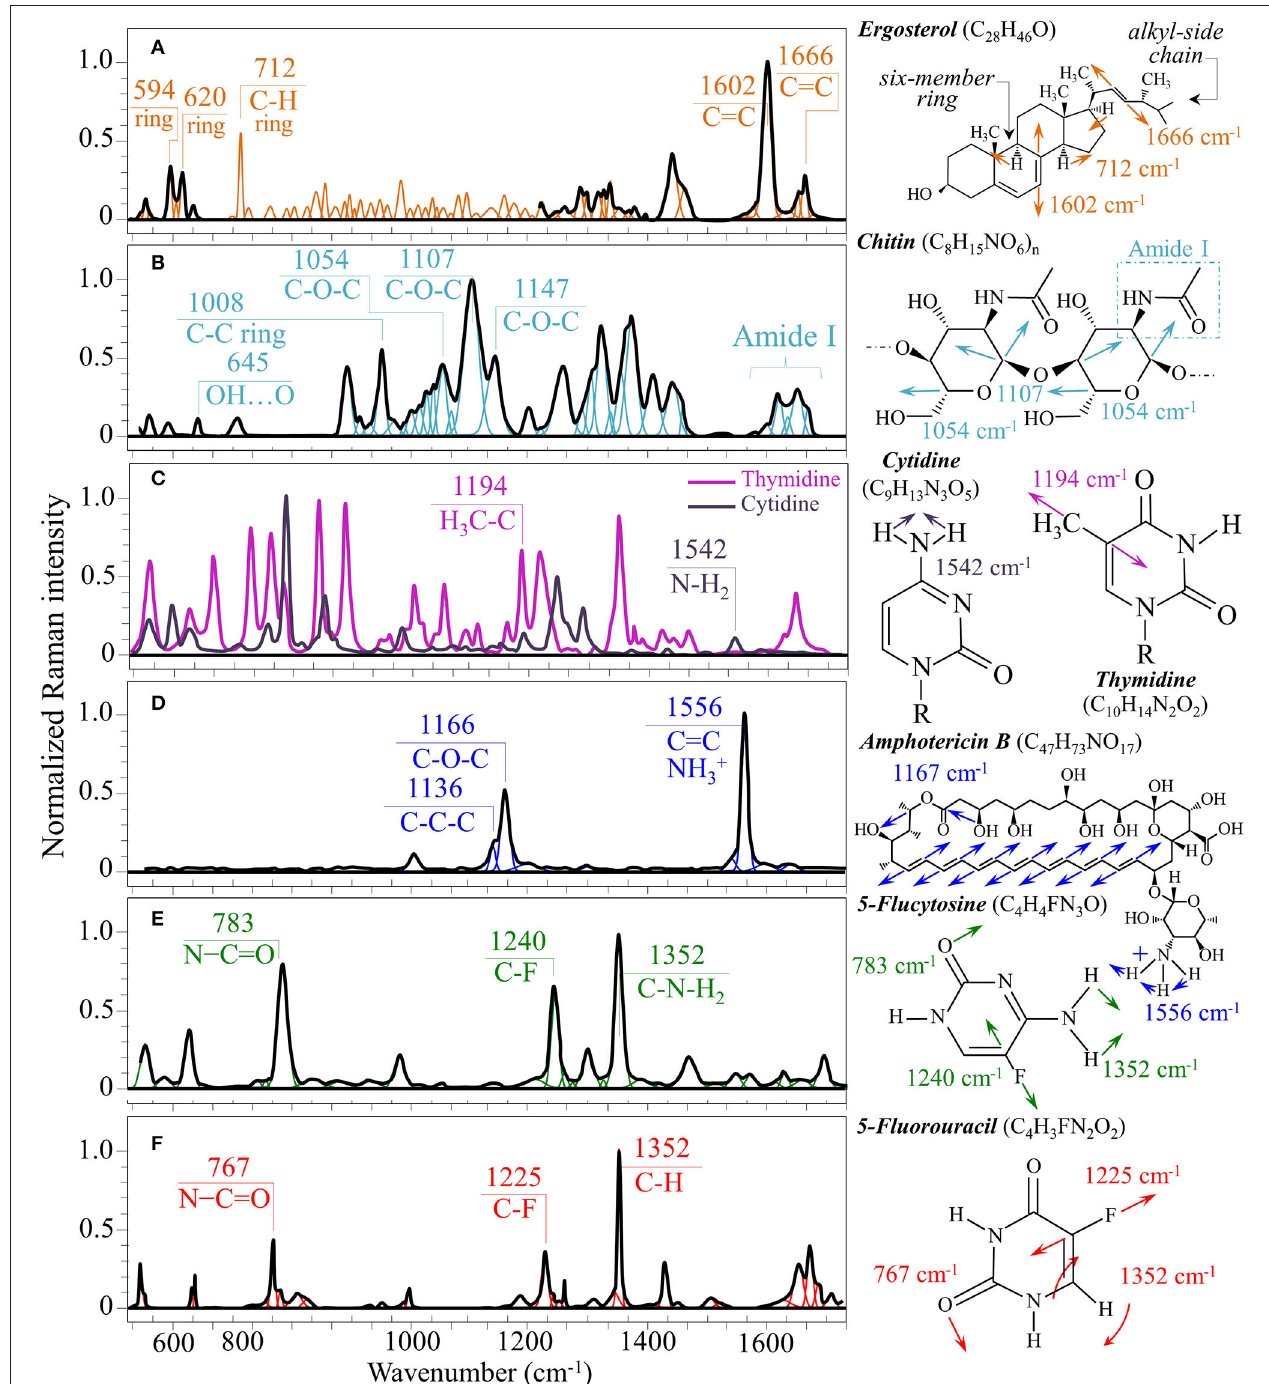
FIGURE 6 | Structures, main vibrational modes, and reference Raman spectra of (A) ergosterol, (B) chitin, (C) cytidine/thymidine, (D) AmB, (E) 5-FU, and (F) 5-FU pure compounds. will be given later in the context of clade response to drug treatments. Finally, note that chitin deacetylation might induce variations in the I 1107 /I 1054 chitin ratio, the higher the degree of deacetylation the lower the ratio (Binias et al., 2016).